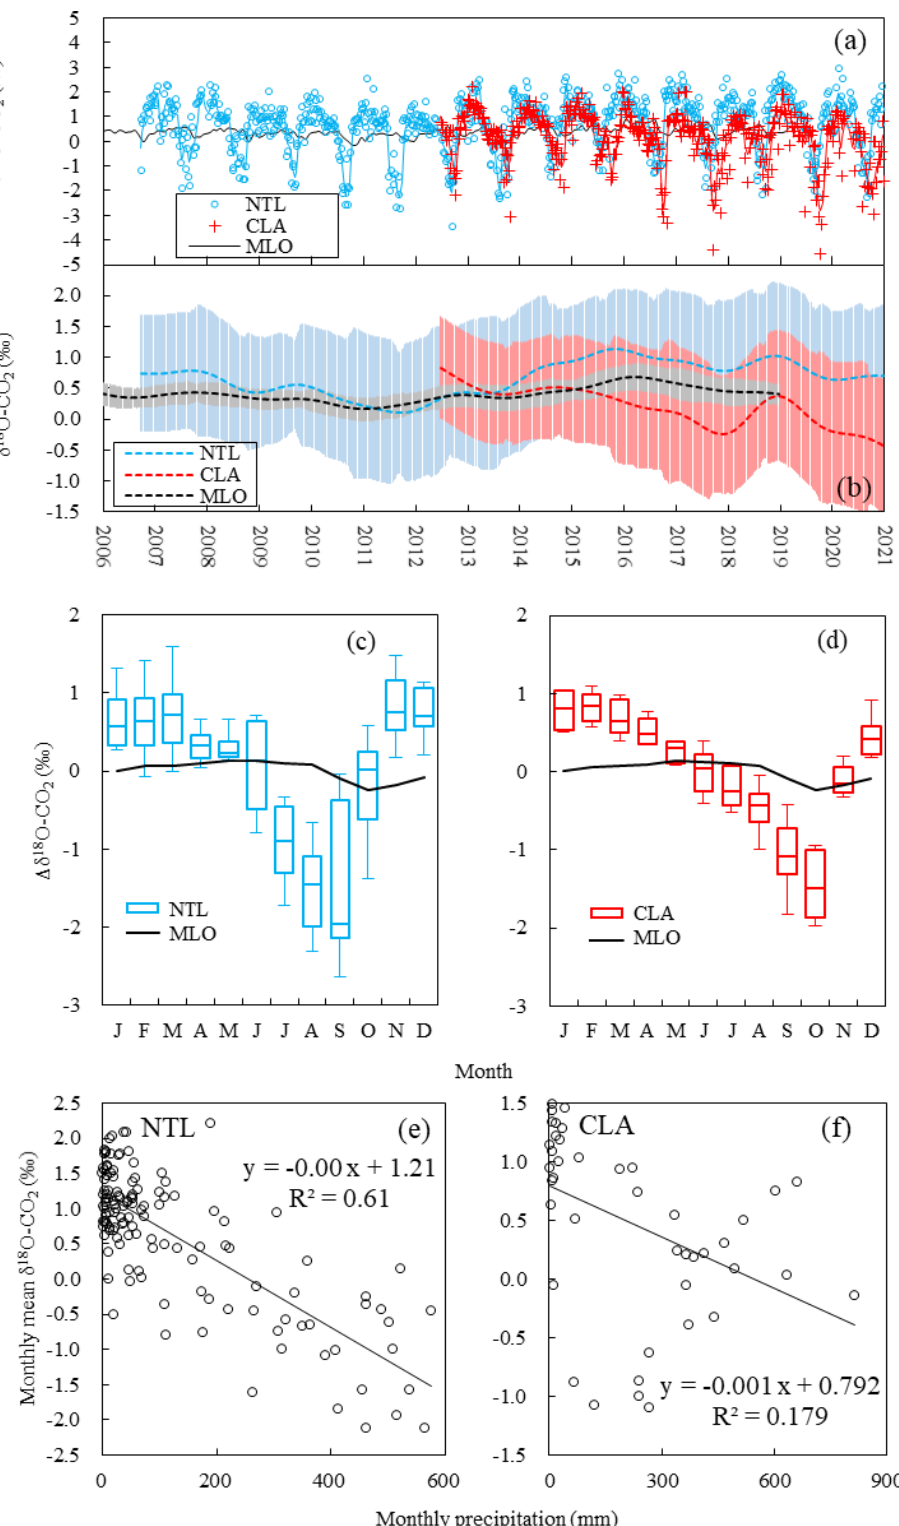
Figure 8. Time series of (a) measured values and (b) the long-term trend for the isotopic ratio of δ 18 O-CO 2 at NTL, CLA, and MLO in 2006–2020, the seasonal variation of δ 18 O-CO 2 at (c) NTL and (d) CLA, and the relationship between monthly precipitation of the state of Uttarakhand and Bangladesh and the monthly mean of δ 18 O-CO 2 at (e) NTL and (f) CLA.